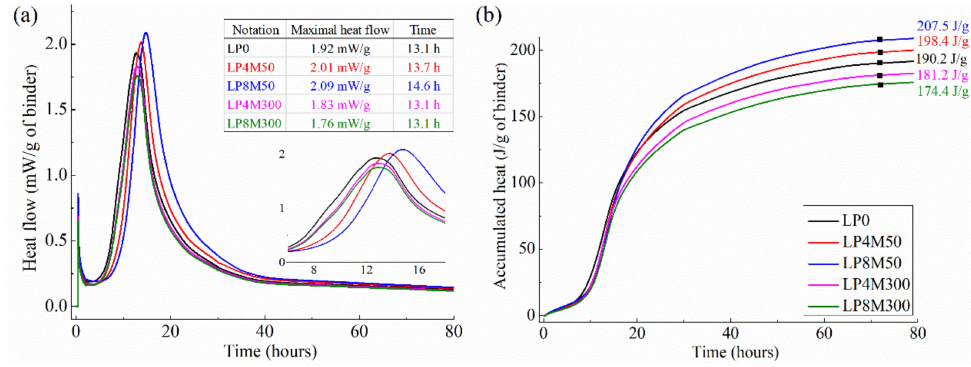
Figure 1. The 3-day hydration heat: ( a ) heat flow and ( b ) the accumulated hydration